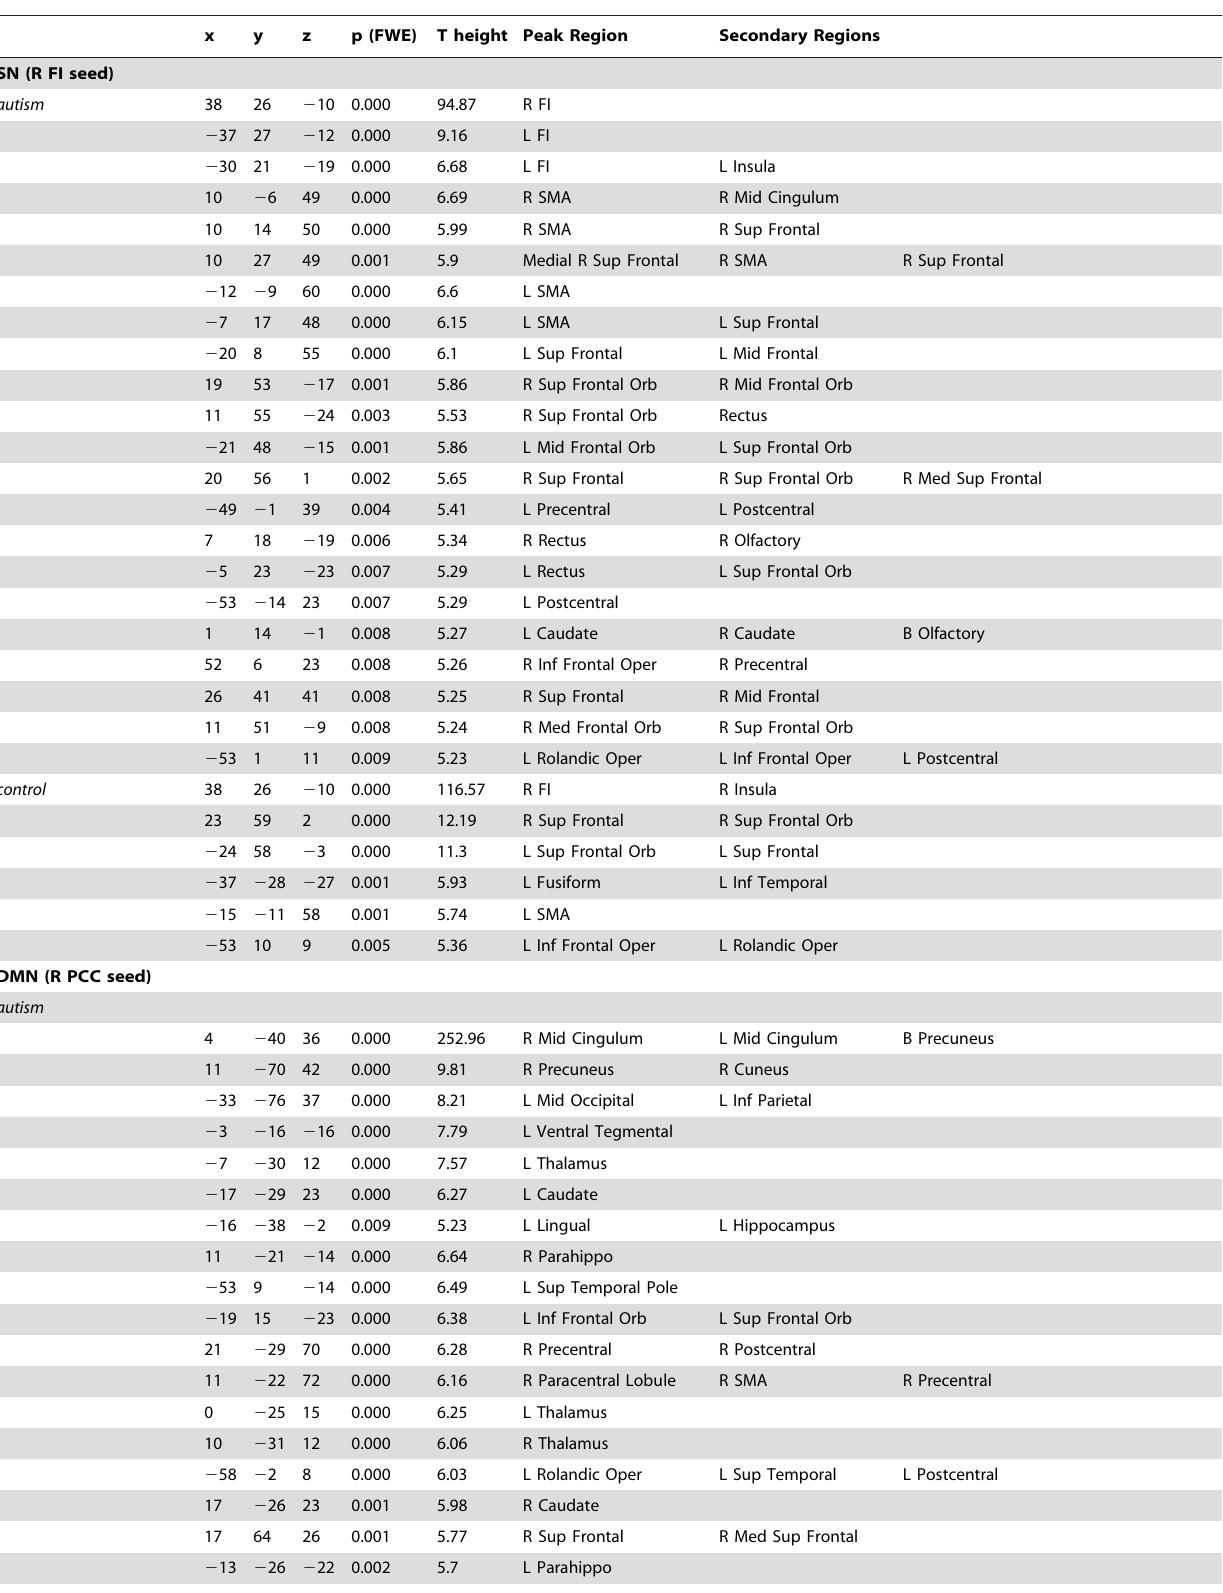
Table 2. MNI coordinates and characteristics of peak voxels and associated clusters of groupwise scMRI maps.